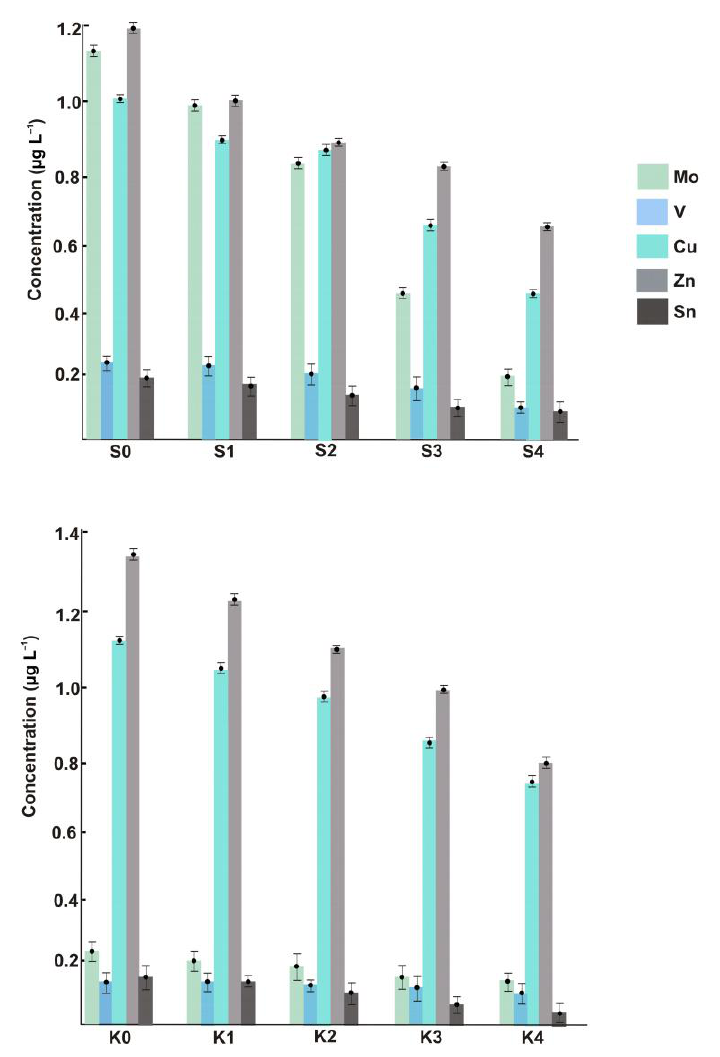
Figure 2. Concentrations of ENPs across different sample locations of the Black Sea.